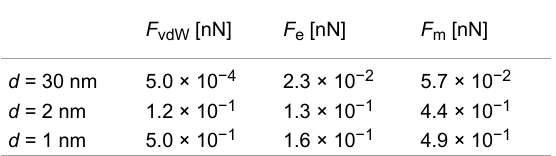
Table 1: Values of the F vdW , F e and F m for three different tip–sample distances, d a . F vdW [nN] F e [nN] F m